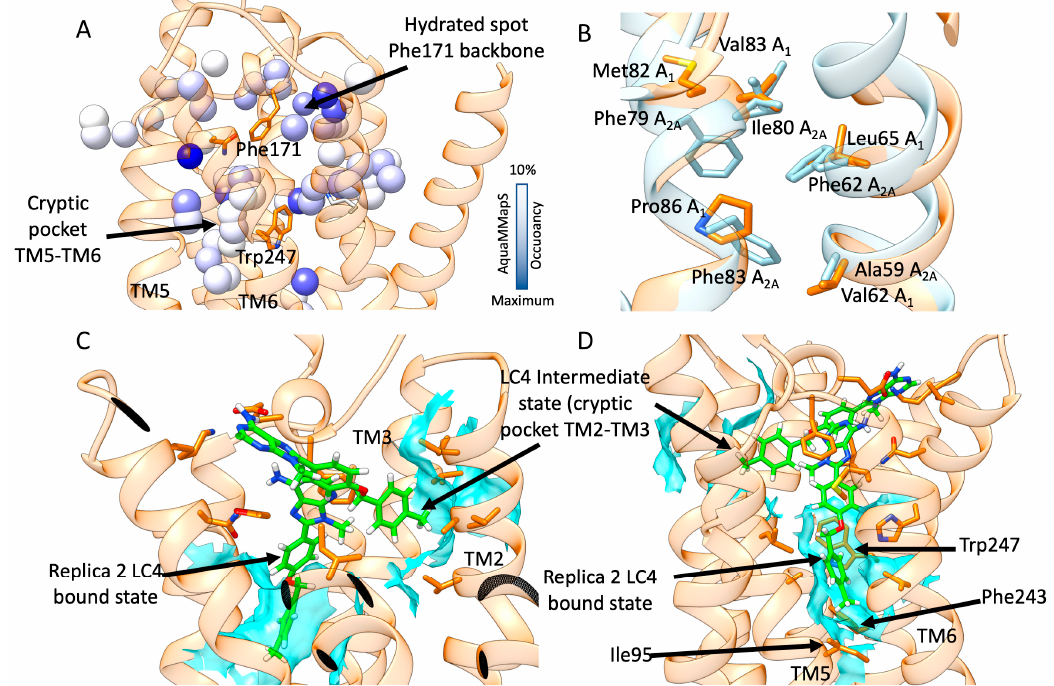
Figure 6. ( A ) Hydrated spots within A 1 AR with AquaMMapSoccupancy > 10%. The cryptic pocket between TM5 and TM6, as well as the spot nearby the Phe171 backbone, are indicated; ( B ) comparison between A 1 AR (orange) and A 2A AR(cyan) at the level of TM2 and TM3—a sub-pocket formed only in A 1 AR during MD simulations, due to different residues and interhelical packing; ( C ) and ( D ) two side views of the two superimposed binding steps of LC4 (green stick) to A 1 AR. Hydrophobic contacts are shown as cyan transparent surfaces.